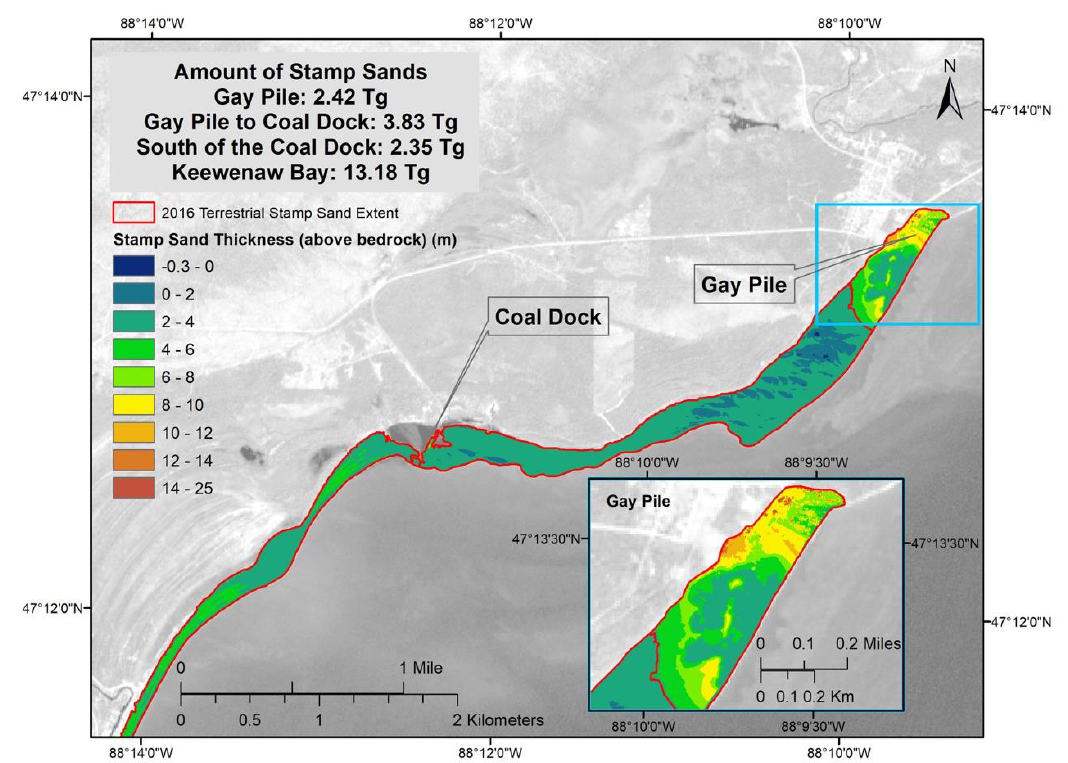
Figure 10. Thickness and amounts of stamp sands along the bay shoreline margin (2016 update). The thickness of coastal stamp sands from the remnants of the original Gay pile (see insert bottom right) to the Traverse River Seawall. Tallies for the southern section are split into two sub-sections between the original pile and the Coal Dock and the Coal Dock to the Seawall. Stamp sand thickness includes the amount redeposited above lake level plus the amount to bedrock (see Methods). The thickness layers are displayed on 2016 Sentinel-2 imagery. Calculated remaining mass for the Gay pile and redeposited masses along the shoreline and into the bay (the latter by historic difference) are also shown. The missing mass (~1Tg short of 22.7 Tg) was removed from the pile (see depressions) for road application.